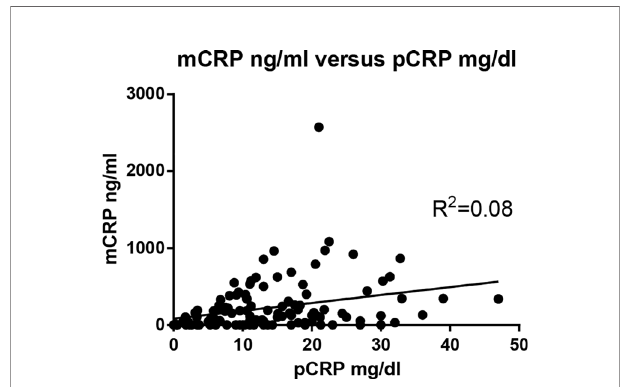
FIGURE 1 | Correlation between mCRP and pCRP concentrations. The correlation between mCRP and pCRP concentration was calculated. Although high-pCRP samples tended to exhibit high mCRP levels, no positive correlation was observed ( R 2 =